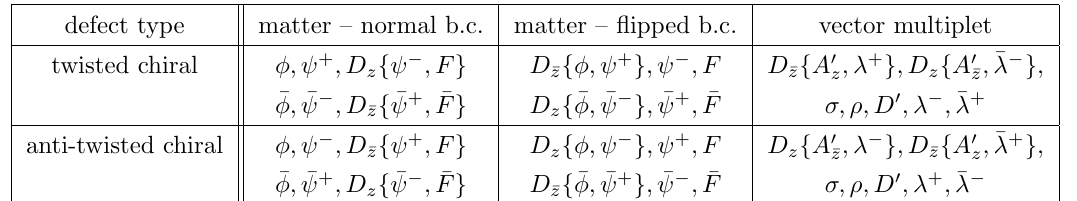
; A 0 ; D 0 denote the (cid:13)uctuations from the given z (cid:22) z